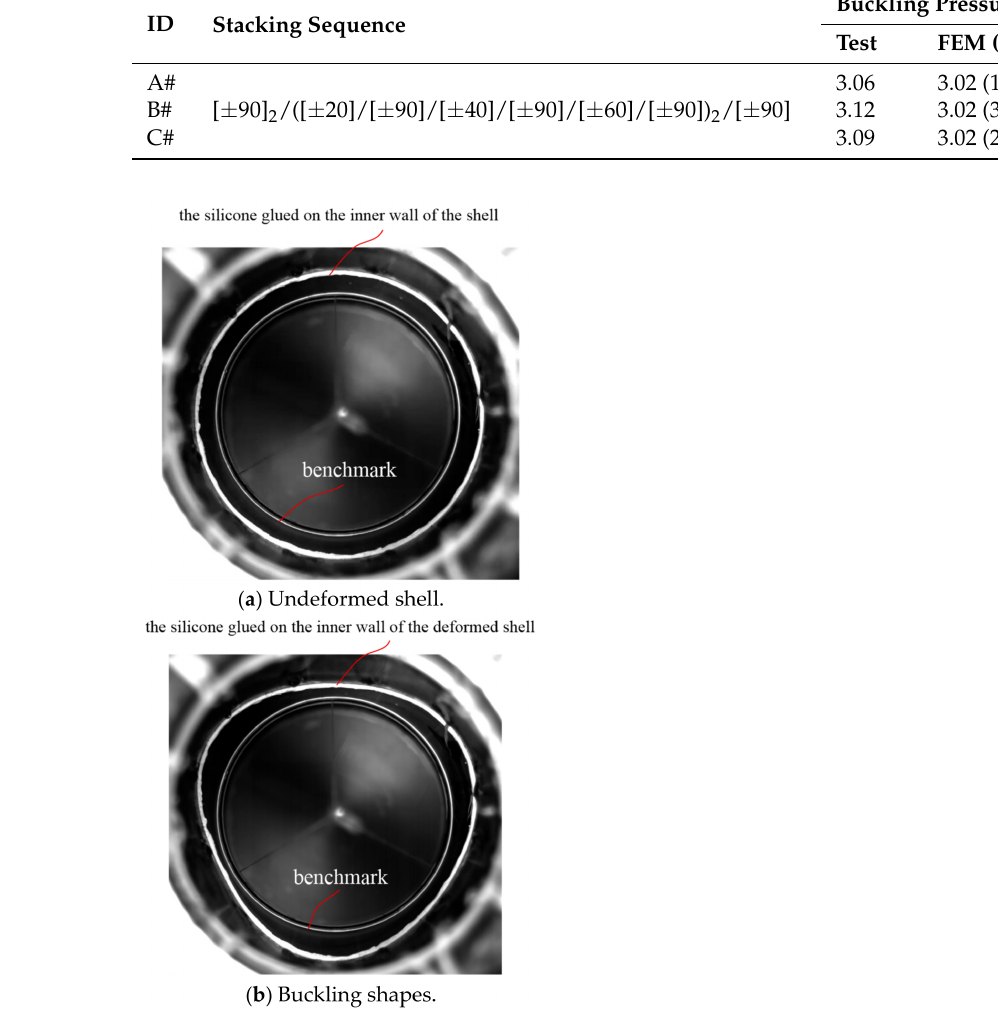
Figure 4. Deformation behavior (A#) observed in